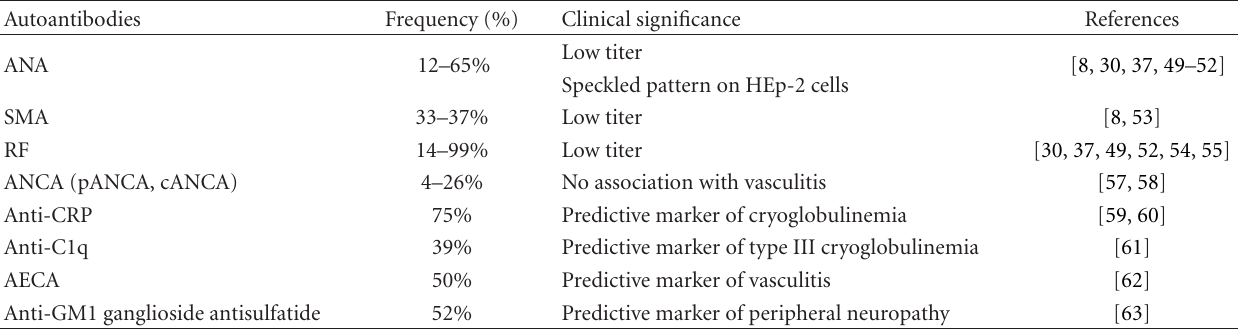
Table 1: Autoantibodies detected in sera of patients with HCV-related